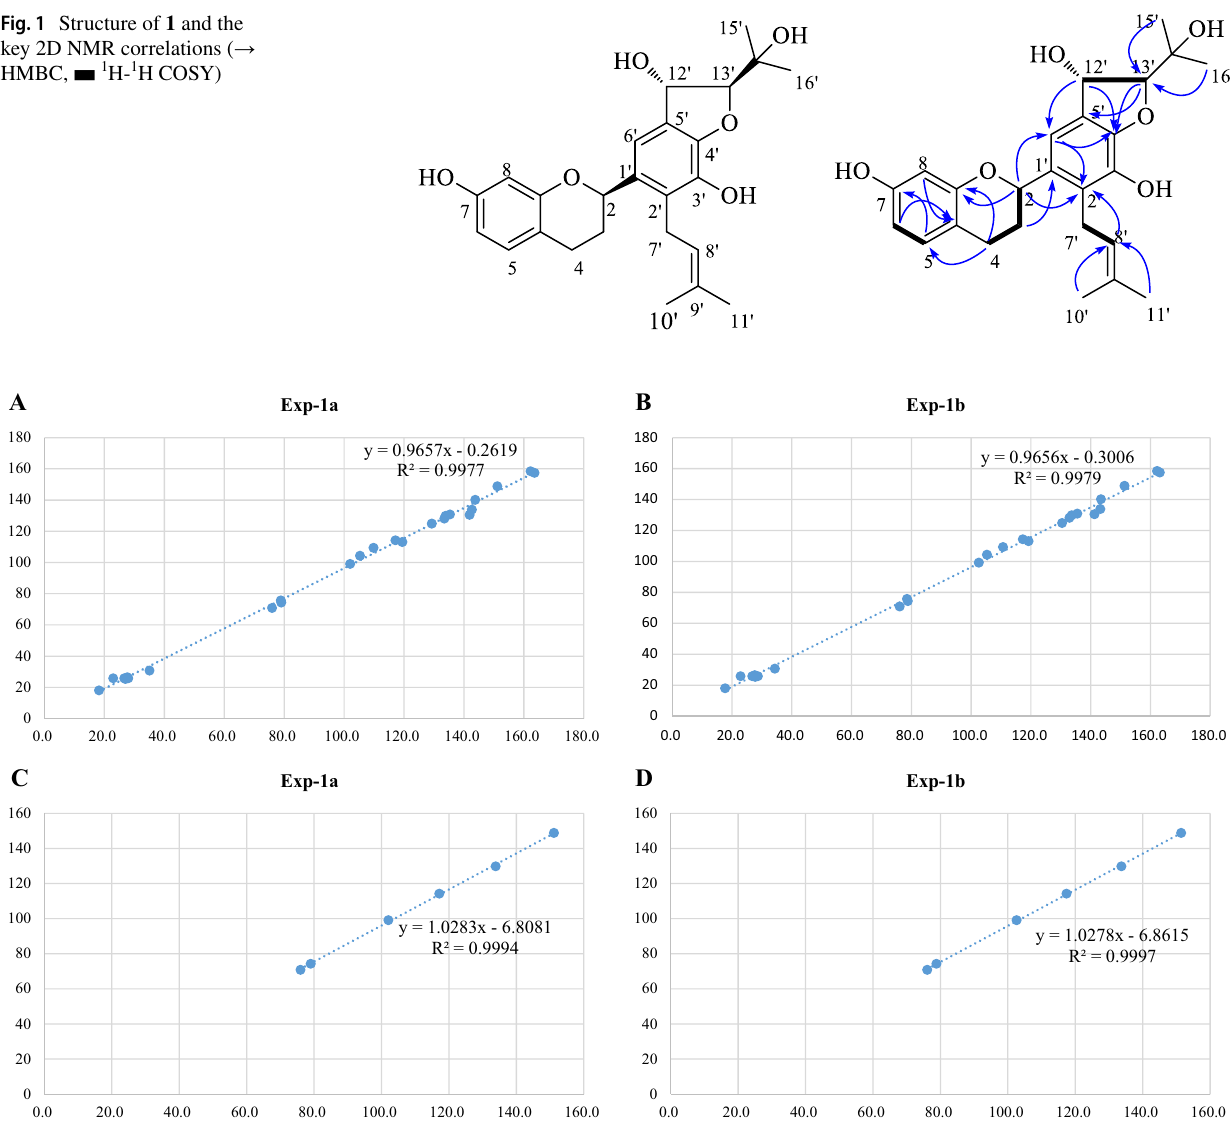
Fig. 2 The correlations between calculated and experimental 13 C NMR data for two possible configurations of 1 ( 1a and 1b ). All carbons ( a and b ) and only C-4 ′ , 5 ′ , 6 ′ , 12 ′ , 13 ′ , 14 ′ ( c and d ) were considered